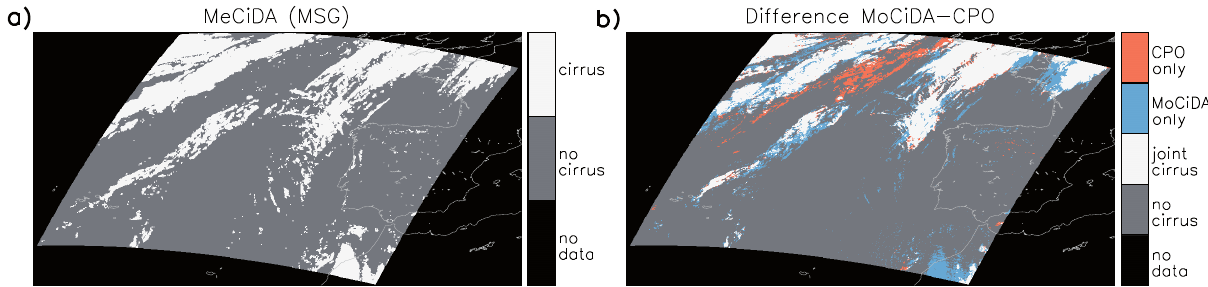
Fig. 1. Sample cirrus products for 11 January 2009, 12:00UTC, west of Spain/Portugal. (a) Cirrus mask from MoCiDA2 applied to the MSG/SEVIRI slot closest in time. (b) Difference between the MoCiDA2 and the CPO cirrus masks (both extracted from MODIS data): red and blue identify cirrus pixels that are detected by CPO or MoCiDA2 alone, white means cirrus pixels that are detected by both algorithms, while grey corresponds to cirrus free pixels.